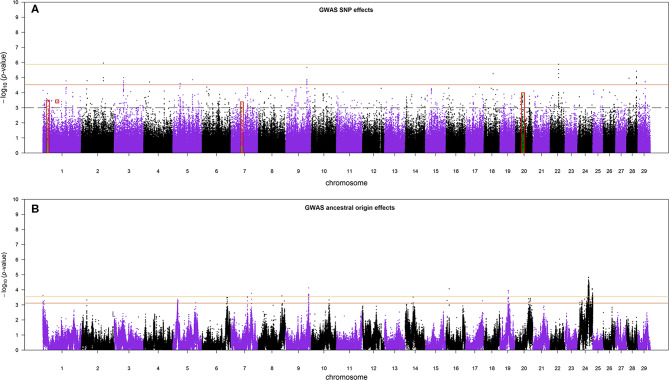
(A) The Manhattan plot of p-values for SNP allele effects and (B) the Manhattan plot of p-values for ancestral origin effects. The red boxes in (A) are the candidate regions for selection signatures that overlap with GWA regions. The colored horizontal lines are false discovery rate thresholds at 0.112 [−log10(p-value) = 5.88] and 0.35 [−log10(p-value) = 4.53] in (A), and at 0.229 [−log10(p-value) = 3.55] and 0.35 [−log10(p-value) = 3.11] in (B), from top to bottom, respectively. The dashed line in (A) is the suggestive p-value threshold of 10−3.